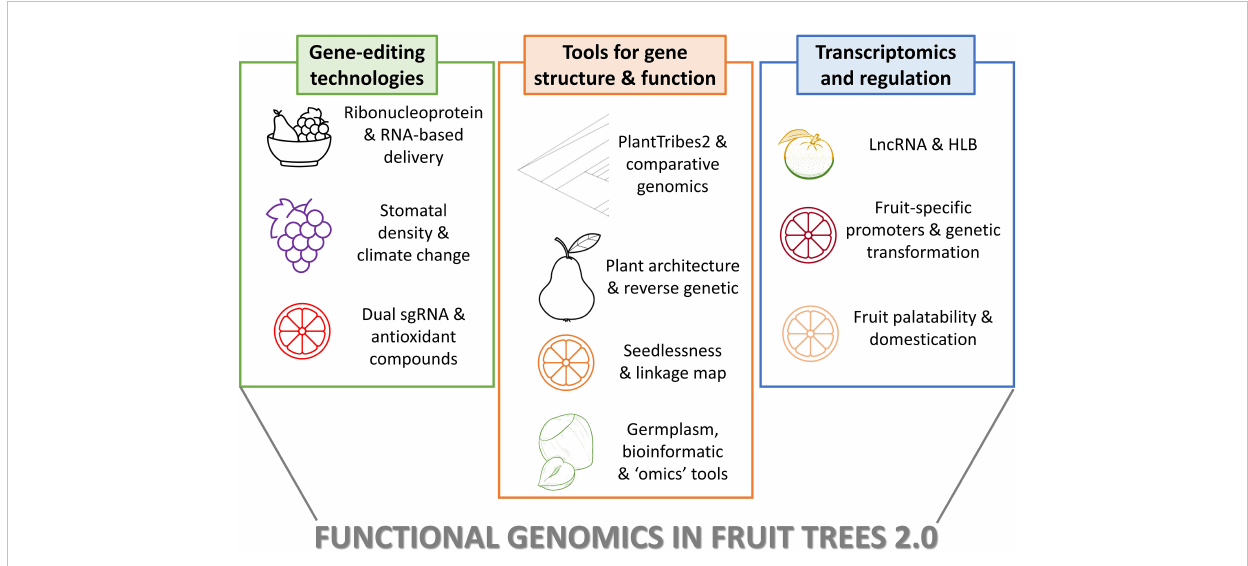
FIGURE 1 Methods and applications showed in the Editorial Functional Genomics in fruits trees 2.0. The fi gure summarizes the main approaches reported in the 10 papers collected in Research Topic, organized in the three main groups as summerized in the Editorial. The plant species and the applications are brie fl y